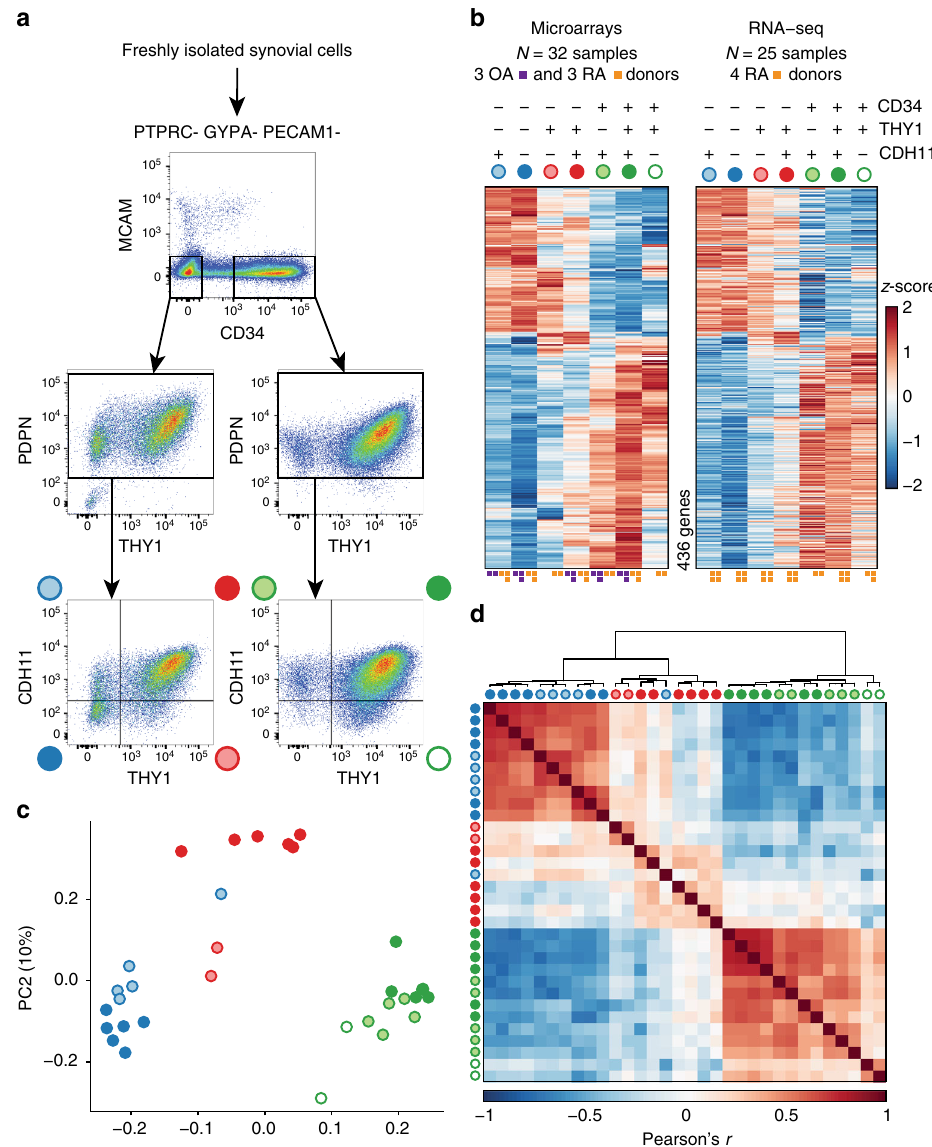
Fig. 1 Distinct protein and mRNA expression between fi broblast subsets. a Gating strategy for synovial fi broblasts with heterogeneous expression of surface proteins. b Analysis of variance (ANOVA) reveals 436 genes with signi fi cant (1% FDR) variation across seven gated populations that are measured and statistically signi fi cant in both microarray and RNA-seq datasets. Each column in the heatmap corresponds to the average of multiple samples of a cell sorting gate. Each square beneath a column represents a donor from which this sample was taken. c Principal component analysis (PCA) with 2,986 genes (1% FDR, ANOVA) in microarray data separates the 32 microarray samples into three subsets: CD34 – THY1 – , CD34 – THY1 + , and CD34 + . d Pairwise Pearson's correlation of microarrays also suggests three major subsets of fi